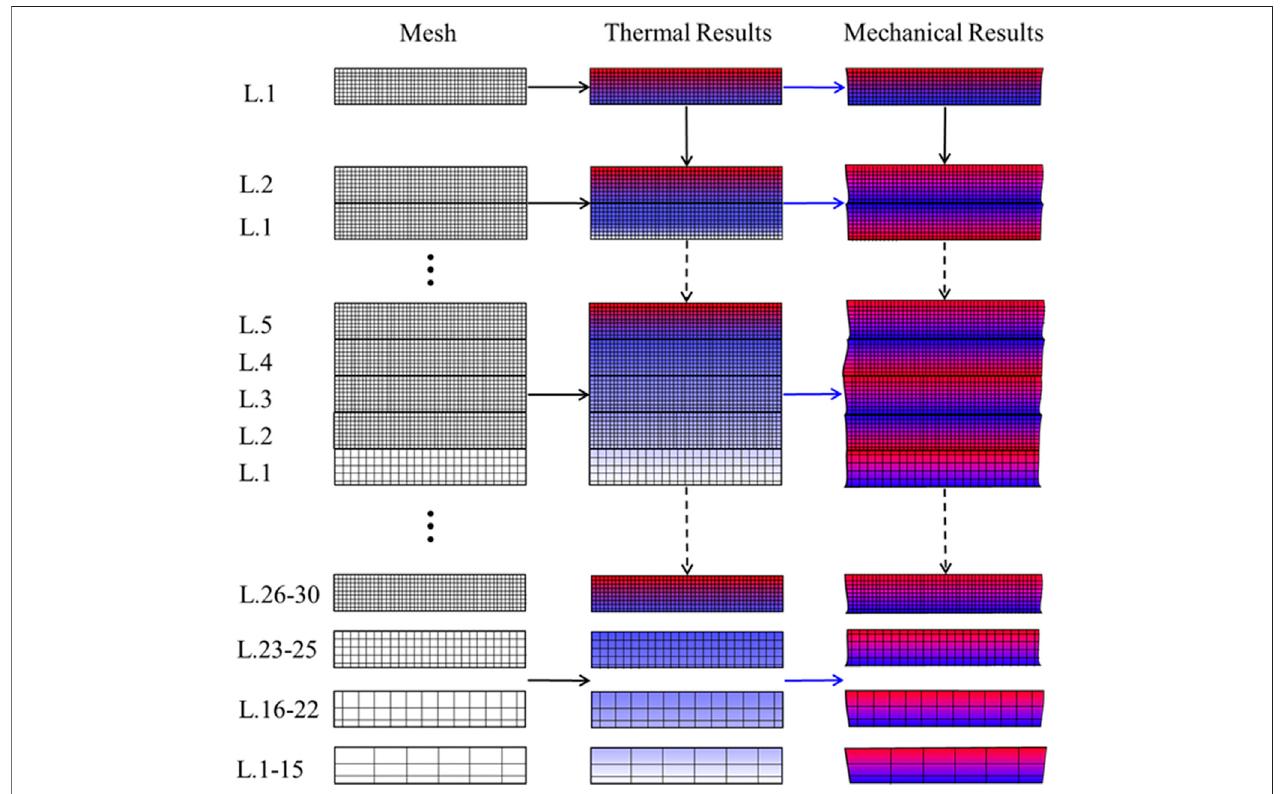
FIGURE5| Mesh-coarseningalgorithmshowingmeshevolutionwiththenumberoflayers.Foreachlayer,anewmodeliscreatedandtheresultsfromtheprevious model are mapped as initial conditions for the new model. A python code is used to transfer nodal displacements between models.